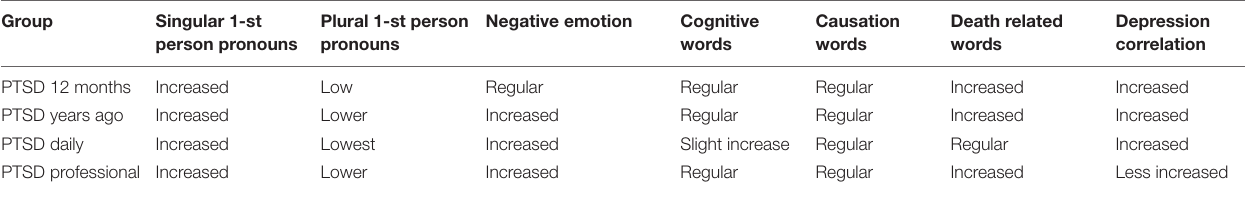
TABLE 2 | Summary of data analysis of language use in PTSD compared to controls.